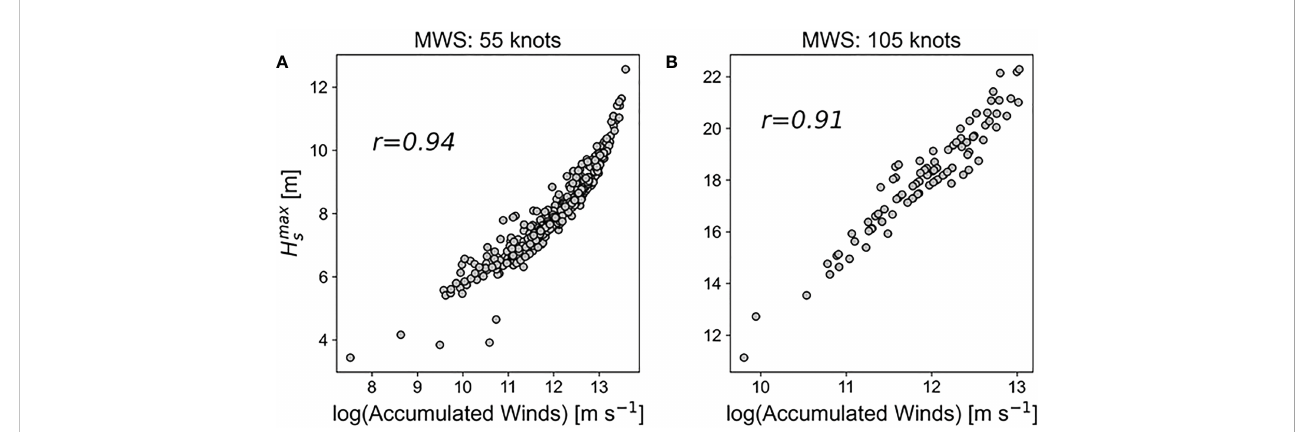
FIGURE 6 Scatter plots of simulated H max s against the total accumulated wind within a TC. The H max s values were obtained from TCs with a constant translation speed ( V fm = 5.25 m s -1 ) and MWS of 55 knots (A) and 105 knots (B) . Accumulated winds were calculated by summing all the wind components aligned with the direction of propagation of the storm, up to 900 km from the TC center. The correlation coef fi cients (r) between H max s and accumulated wind are indicated in each scatter